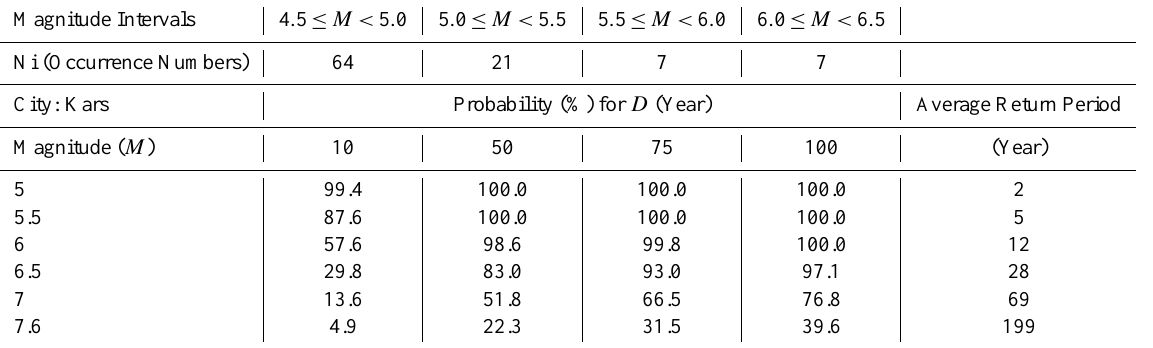
Table 3n. Earthquake occurrence probability (%) for D (Year) for Kars city. Magnitude